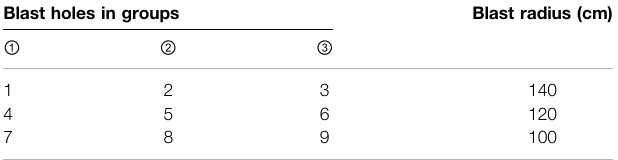
TABLE 5 | Blast radius for each group of blast